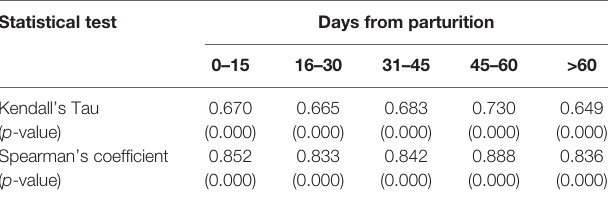
TABLE 1 | The conformance between the lactating donkey ’ s serum and milk samples based on the ELISA S/P% results. Statistical test